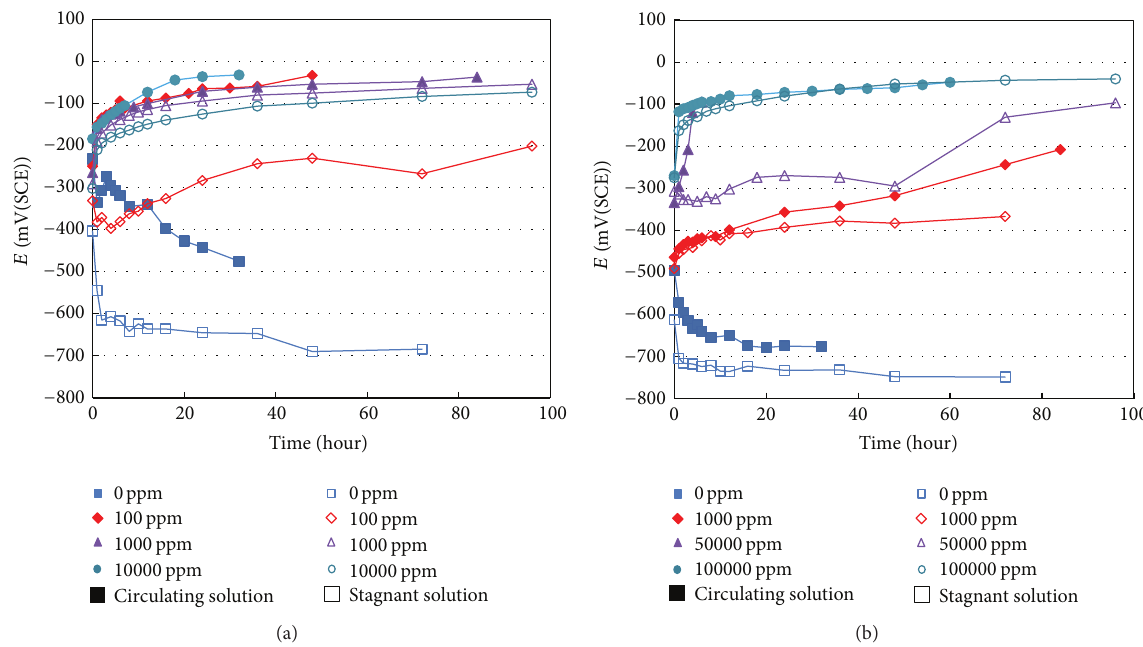
Figure 2: Open circuit potential with immersion time by nitrite addition in circulating (solid symbol) and stagnant (open symbol) simulated cooling water at 25 ∘ C; (a) carbon steel and (b) ductile cast iron.